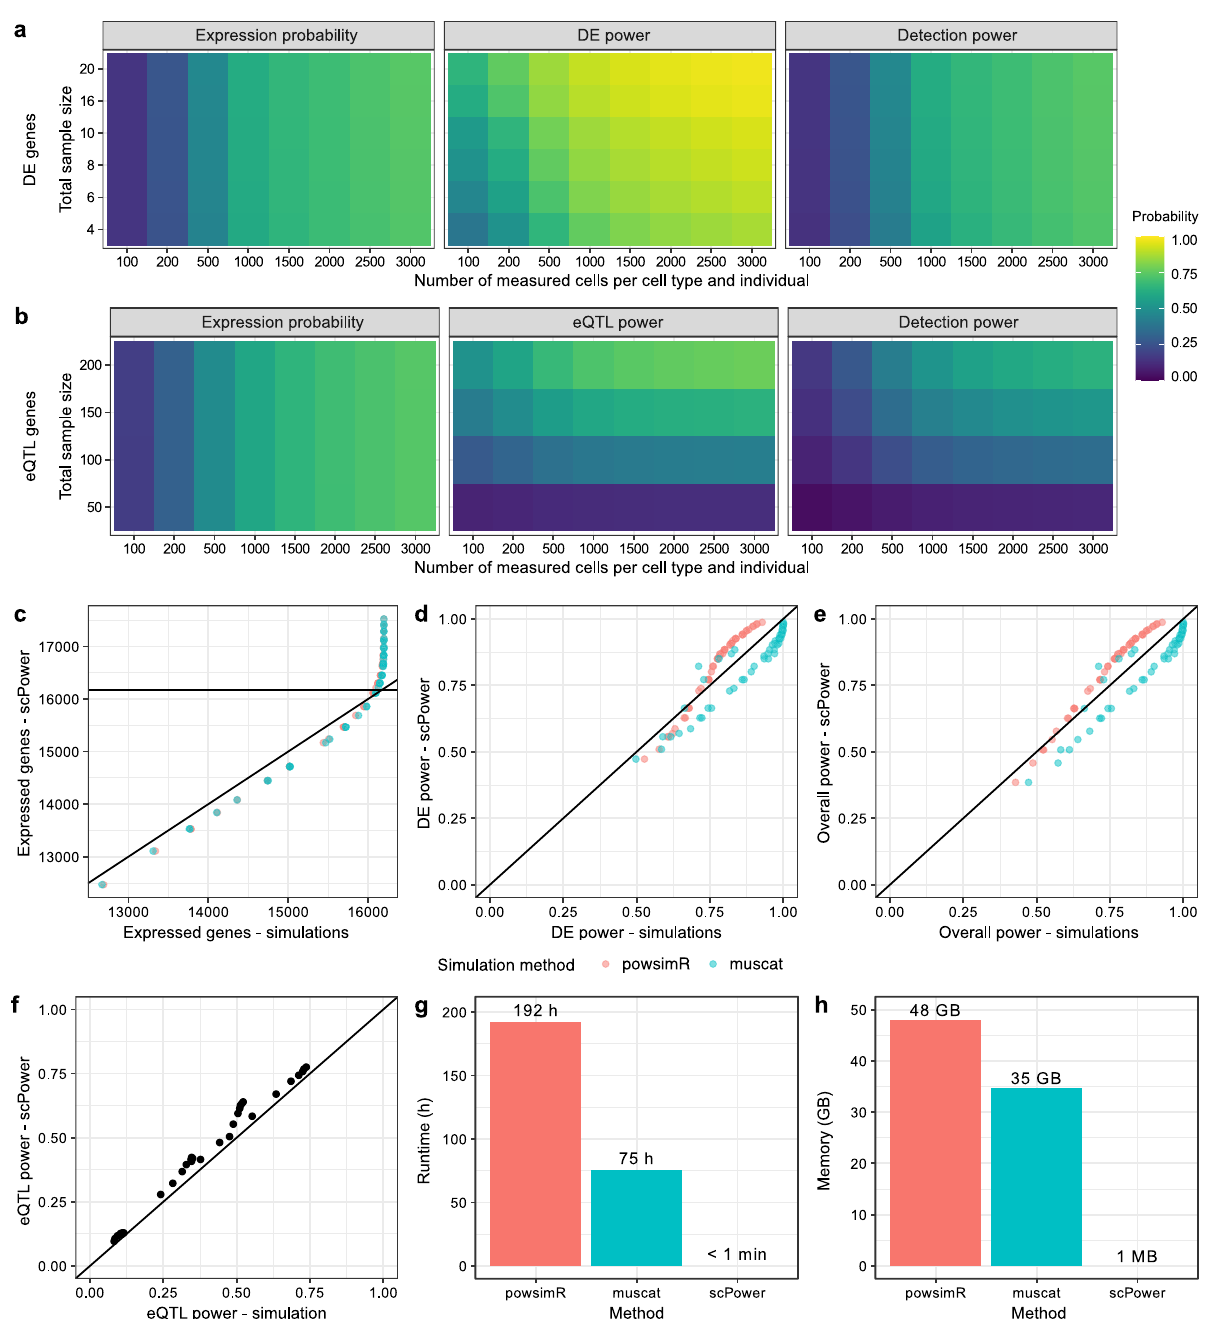
Fig. 3 Expression probability, DE/eQTL power and overall detection power and their validation in simulation studies. Power estimation using data driven priors for DE genes ( a ) and eQTL genes ( b ) dependent on the total sample size and the number of measured cells per cell type. The detection power is the product of the expression probability and the power to detect the genes as DE or eQTL genes, respectively. The fold change for DEGs and the R 2 for eQTL genes were taken from published studies, together with the expression rank of the genes. For ( a ), the Blueprint CLL study with comparison iCLL vs mCLL was used, for ( b ), the Blueprint T cell study. The expression pro fi le and expression probabilities in a single cell experiment with a speci fi c number of samples and measured cells was estimated using our expression prior, setting the de fi nition for expressed to > 10 counts in more than 50% of the individuals. Multiple testing correction was performed by using FDR adjusted p values for DE power and FWER adjusted p values for eQTL power. The probabilities calculated in ( a ) were veri fi ed by the simulation-based methods powsimR and muscat with each point representing one parameter combination. f The eQTL power of ( b ) could be replicated with a self-implemented simulation. Runtime ( g ) and memory requirements ( h ) were drastically higher in the simulations than for our tool scPower during the evaluations of ( c – e ), showing the strength of our analytic